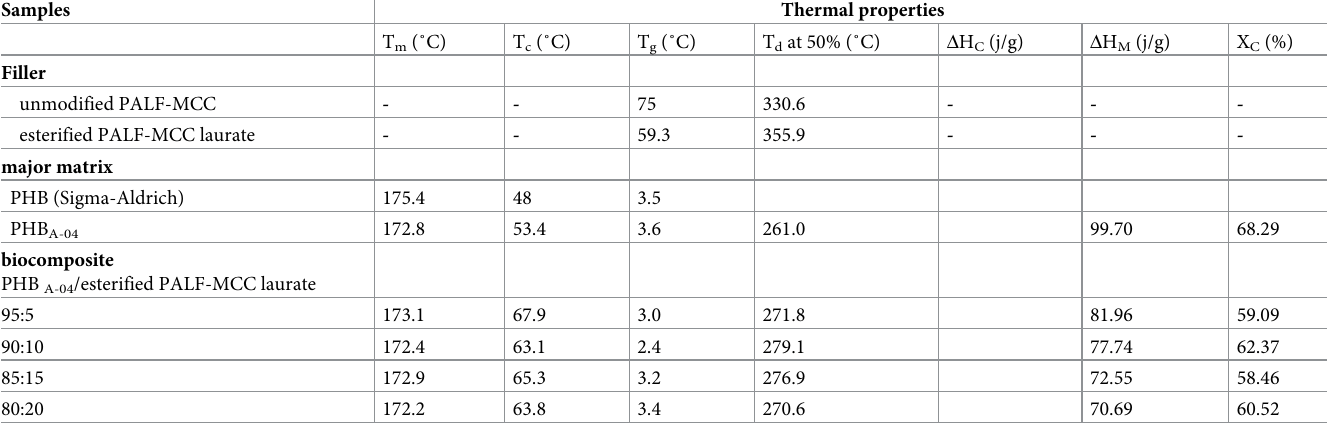
Table 2. Thermal analysis by thermal gravimetric analysis (TGA) and differential scanning calorimetry (DSC) for commercialized PHB, produced PHB A-04 and produced PHB/esterified PALF-MCC at the rate of 10˚C/min.